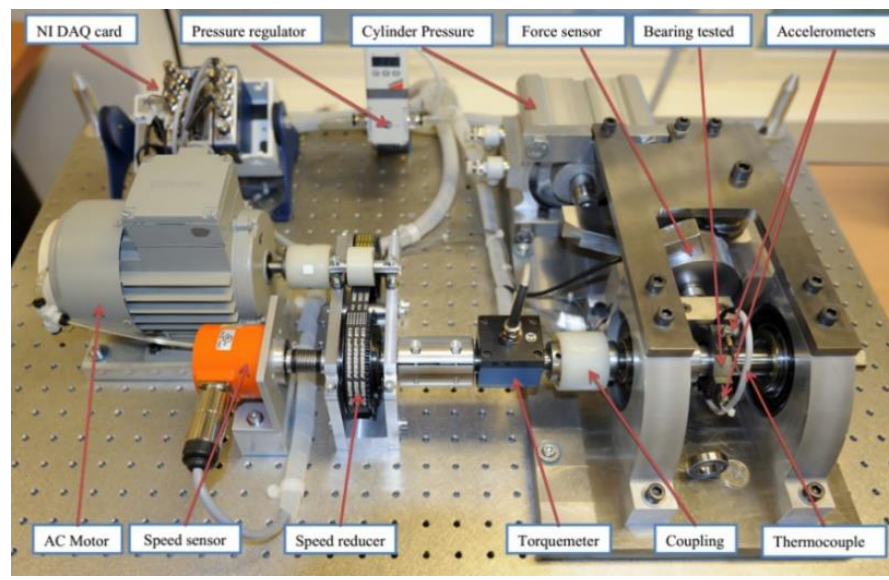
Figure A2. Overview of PRONOSTIA.